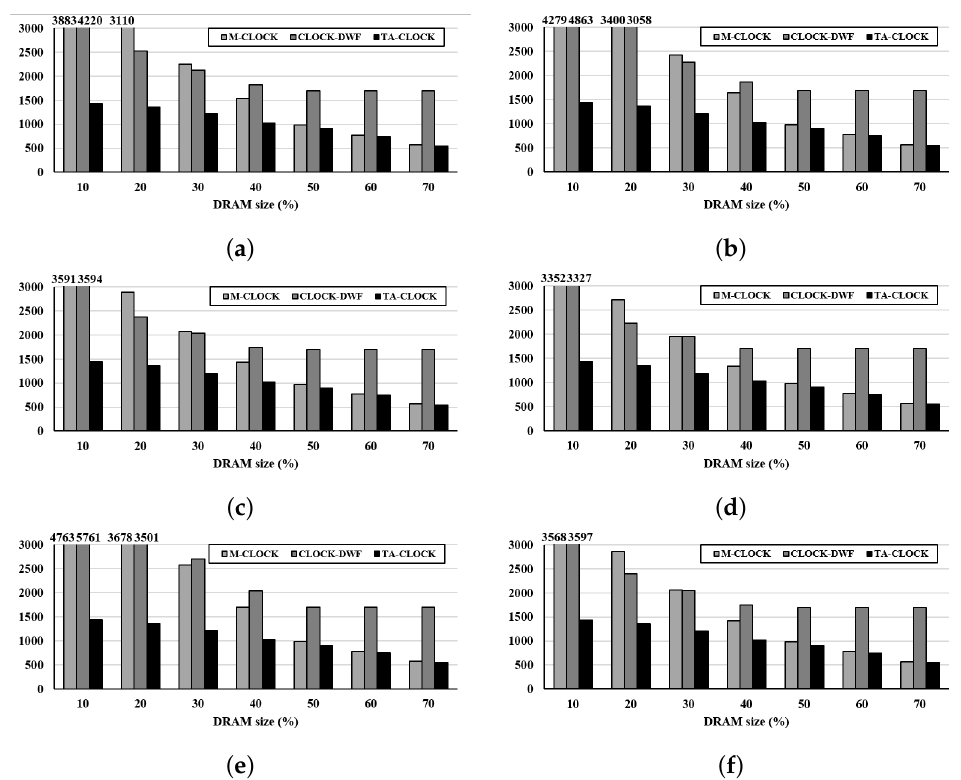
Figure 8. Number of migrations between DRAM and PCM (values of 3000 or higher are indicated as 3000). ( a ) basicmath; ( b ) blowfish; ( c ) dijkstra; ( d ) patricia; ( e ) qsort; ( f )